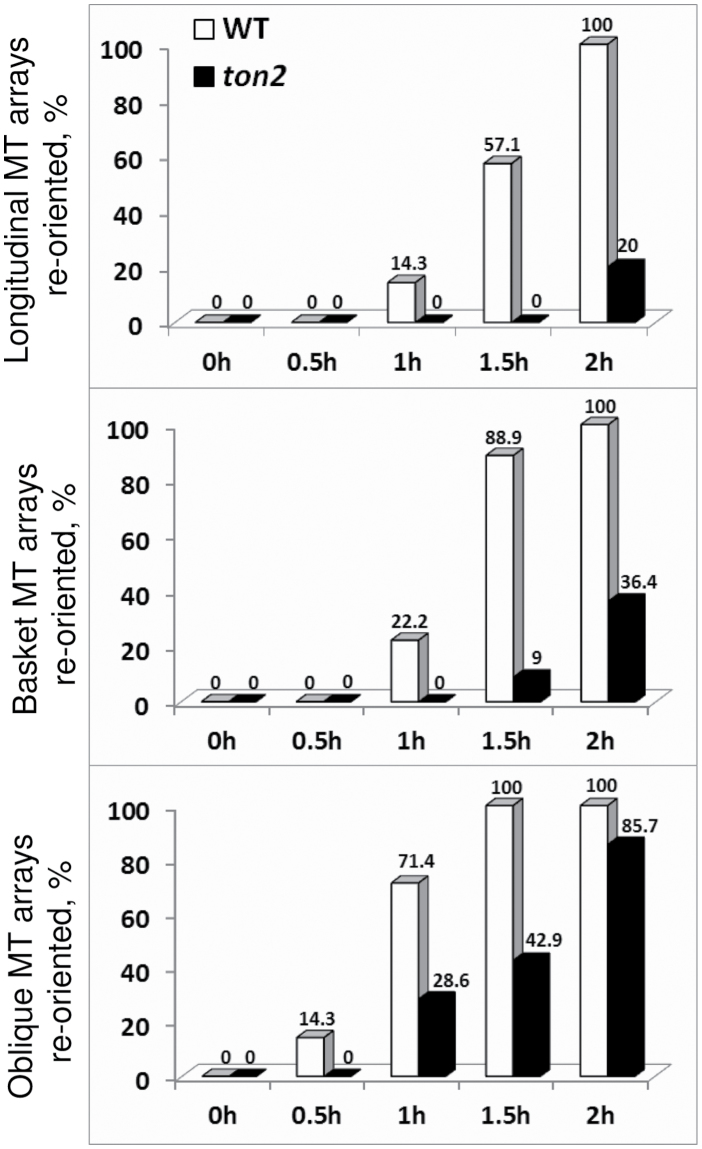
Reorientation into transverse microtubule arrays starting from different microtubule configurations. Bars show the percentage of cell with longitudinal (upper), basket (middle graph) and oblique (lower) microtubule arrays reoriented into transverse orientation. For each configuration 6 cells from 2 different plants were analysed.